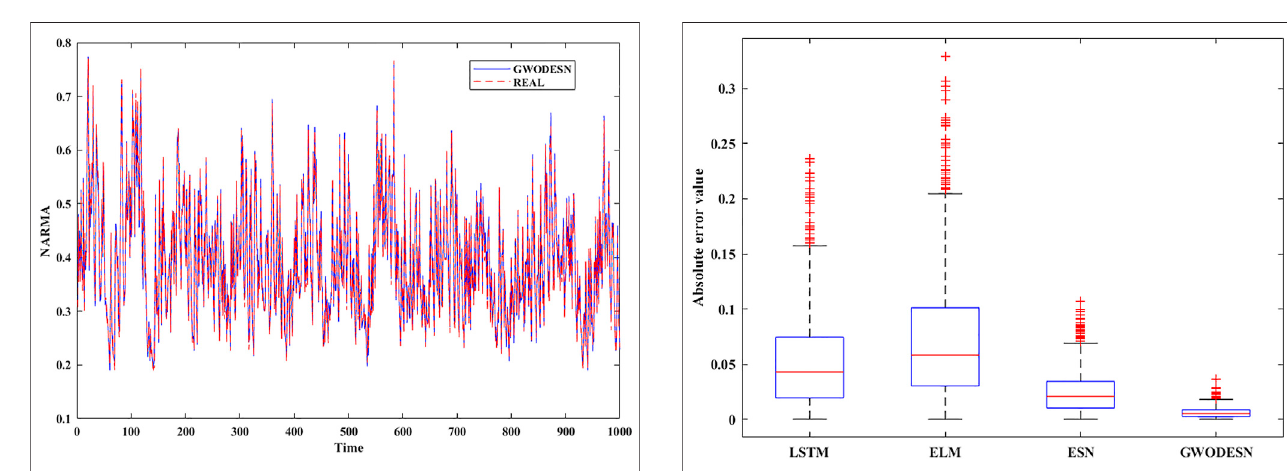
FIGURE 7 | The absolute error box diagram for NARMA.